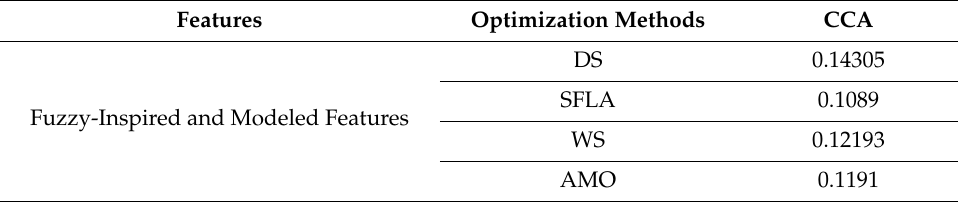
Table 9. CCA at various optimization techniques with di ff erent features for normal and CVD cases.